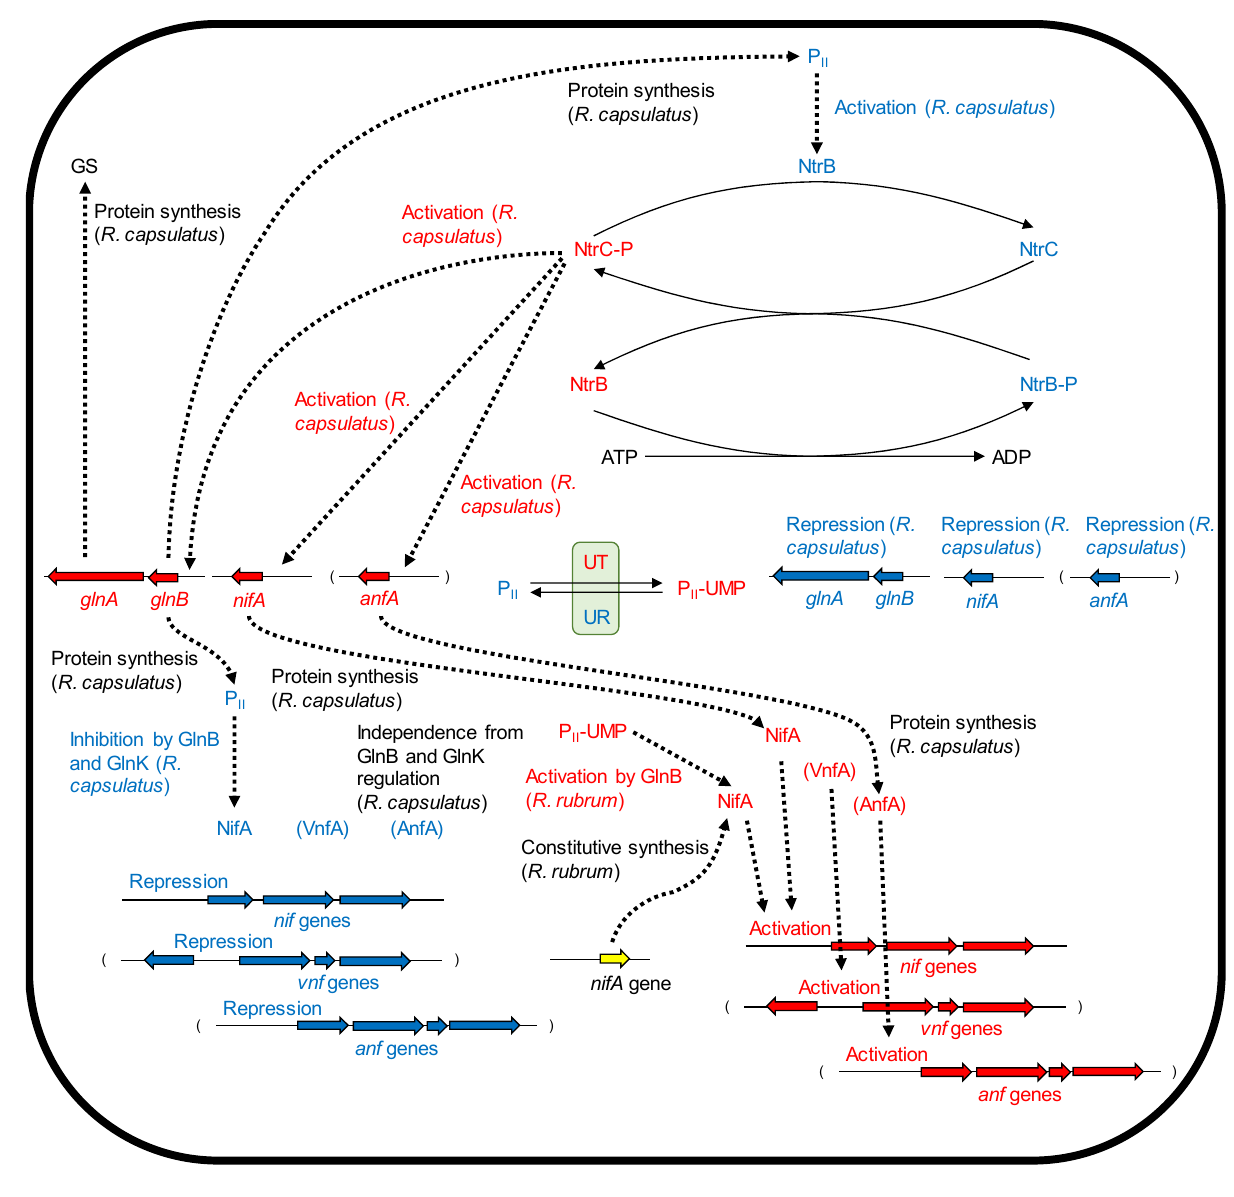
Figure 1. Transcriptional regulations of nitrogenase and GS activities in PNSB. Protein designations, gene maps and designations, and biochemical responses with red and blue colors mean their states under ammonia-deficient and ammonia-sufficient conditions, respectively. UR (uridyl-removing enzyme) and UT (uridyltransferase) activities are controlled by nitrogen status (2-oxoglutarate/glutamine) [64] . In a model shown in Escherichia coli , the NtrB autophosphorylation activity is inhibited by P II [65] .